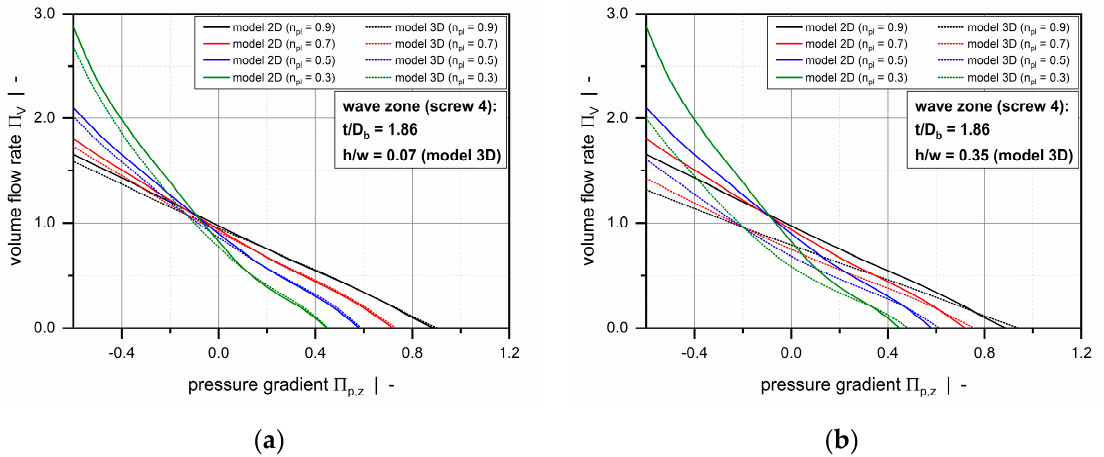
Figure6. Comparisonbetweenthetwo-andthree-dimensionalmelt-conveyingmodels: Screwcharacteristic Figure 6. Comparison between the two- and three-dimensional melt-conveying models: Screw curves for the wave zone of screw 4 with t / D b = 1.86, showing the pumping capability of a wave characteristic curves for the wave zone of screw 4 with t/D b = 1.86, showing the pumping capability peak ( a ) and valley ( b of a wave peak ( a ) and valley ( b ).